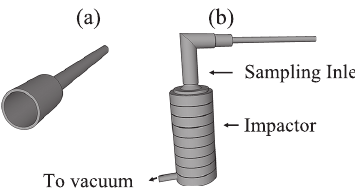
Fig. 8 Illustrations of (a) a standardized entrainment tube and; (b) its position with respect to a stacked, cascade im- pactor for aerodynamic particle size determination.